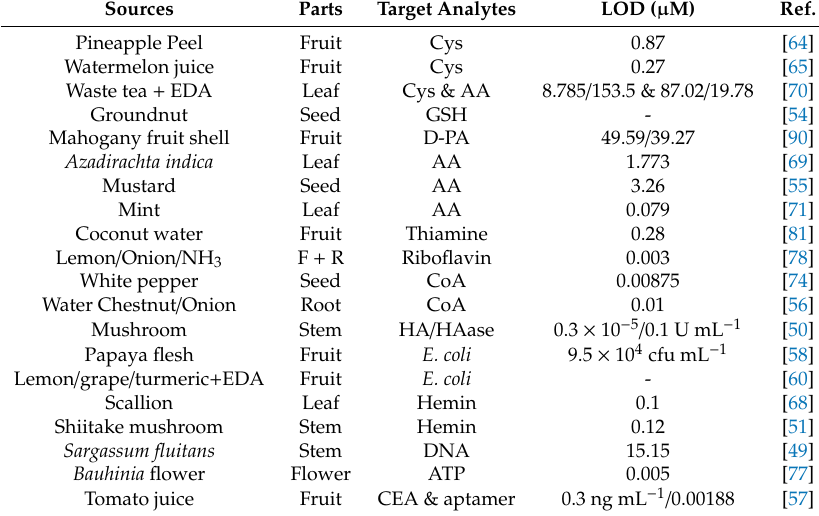
Table 4. The applications of plant part-derived CDs for the sensing of various biomolecules. Abbreviations: LOD, limit of detection; F + R, fruit + root; cfu, colony-forming unit.